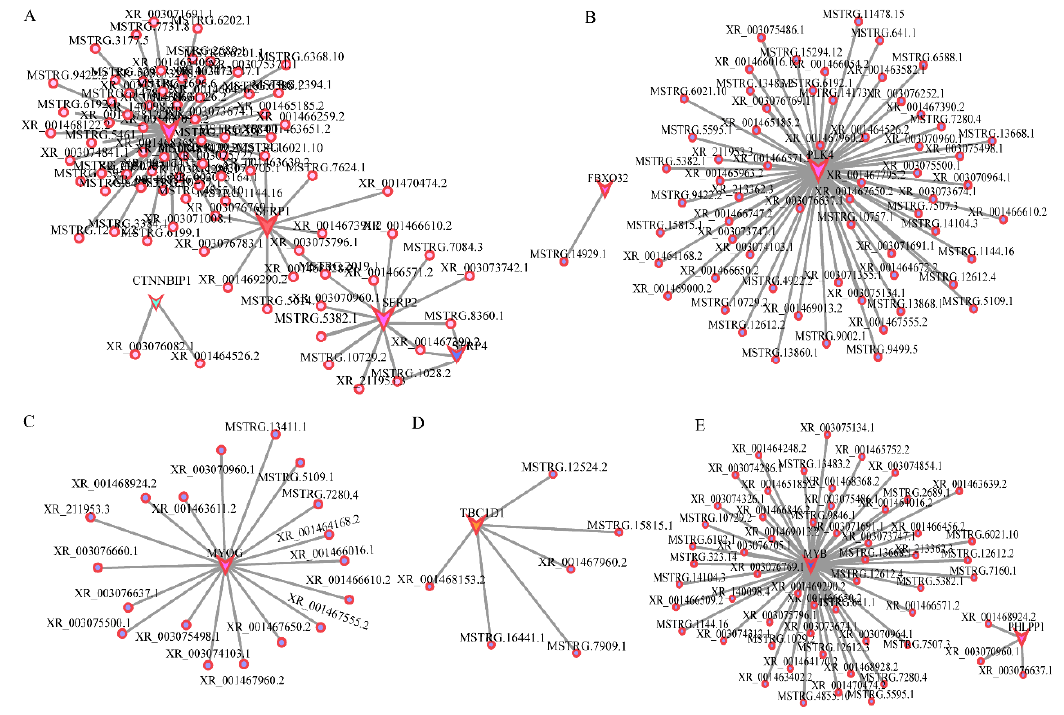
Figure 6. Interaction of lncRNA and mRNA. ( A ). The Wnt signal pathway; ( B ). The FoxO signal pathway; ( C ). MYOG; ( D ). The AMPK signal pathway; ( E ). The PI3K-AKT signal pathway. Polygon represents mRNA, and the circle represents lncRNA, respectively. Different colors represent different mRNAs, and polygon size represents the degree of enrichment, respectively.